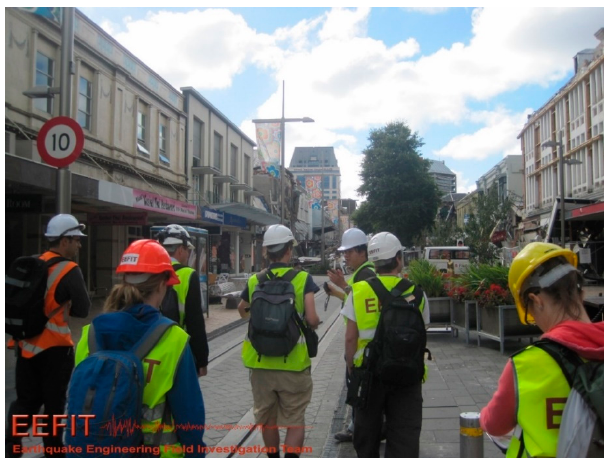
Figure 4. EEFIT earthquake reconnaissance mission after the Christchurch earthquake in 2011. Source: [57] .